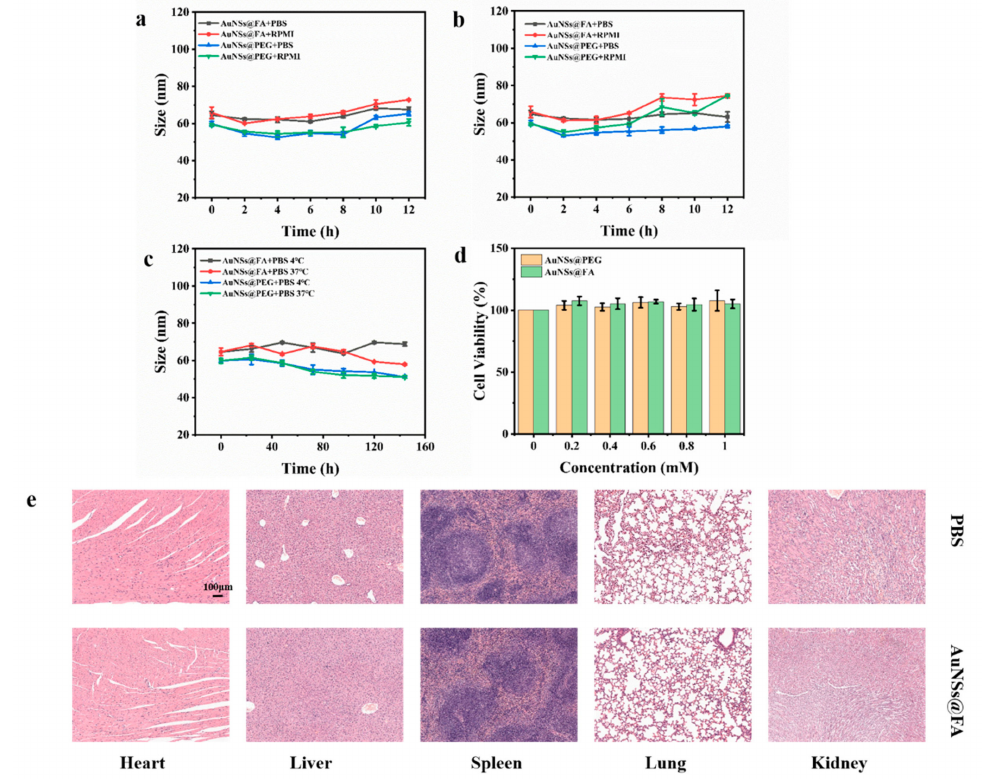
Figure 4. Stabilities of AuNSs@PEG and AuNSs@FA cultured in PBS and RPMI at 4 ◦ C ( a ) or at 37 ◦ C ( b ) for 12h. ( c ) Stabilities of AuNSs@PEG and AuNSs@FA cultured in PBS within 1 week at 4 ◦ C and at 37 ◦ C. ( d ) Cell viabilities of L929 cells at different Au concentrations of AuNSs@PEG and AuNSs@FA. ( e ) H&E slice selection sections of the major organs (heart, liver, spleen, lung, and kidney) on day